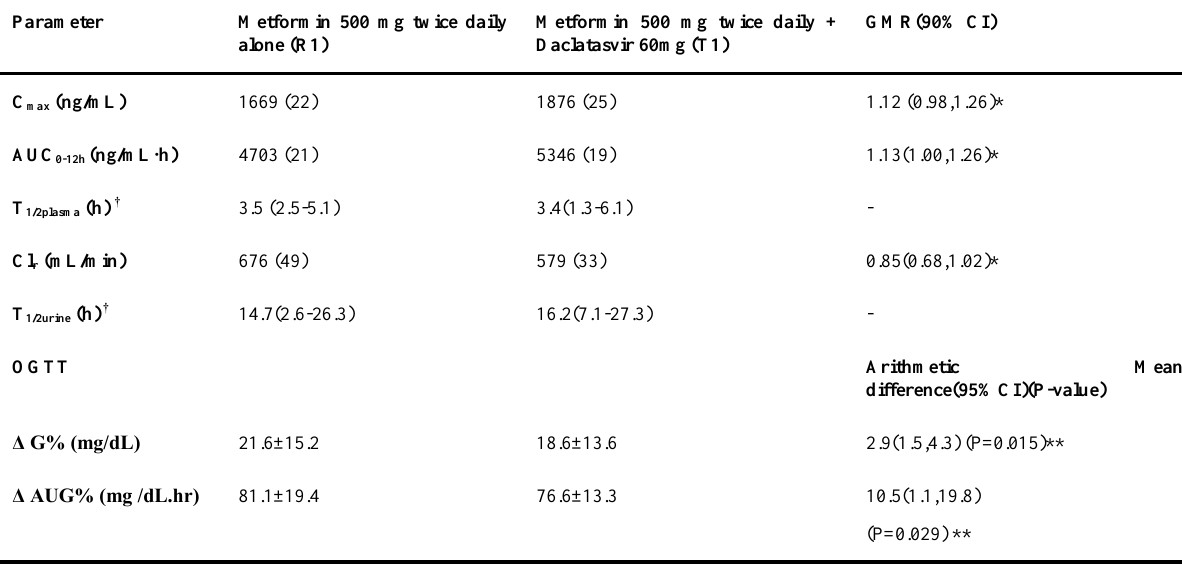
Table 2. Pharmacokinetics and OGTT parameters of metformin 500 mg either alone or with daclatasvir 60 mg Parameter